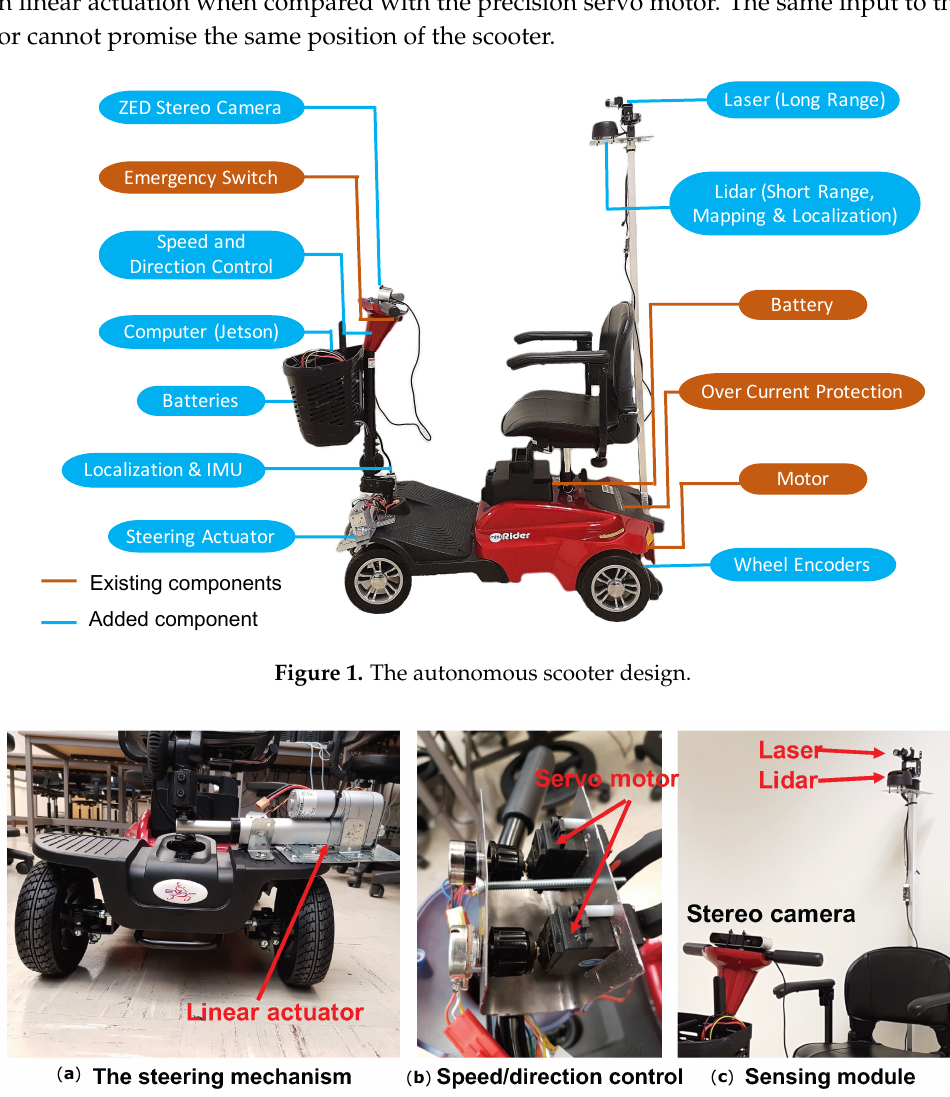
Figure 2. The steering mechanism, speed/direction control, and sensing